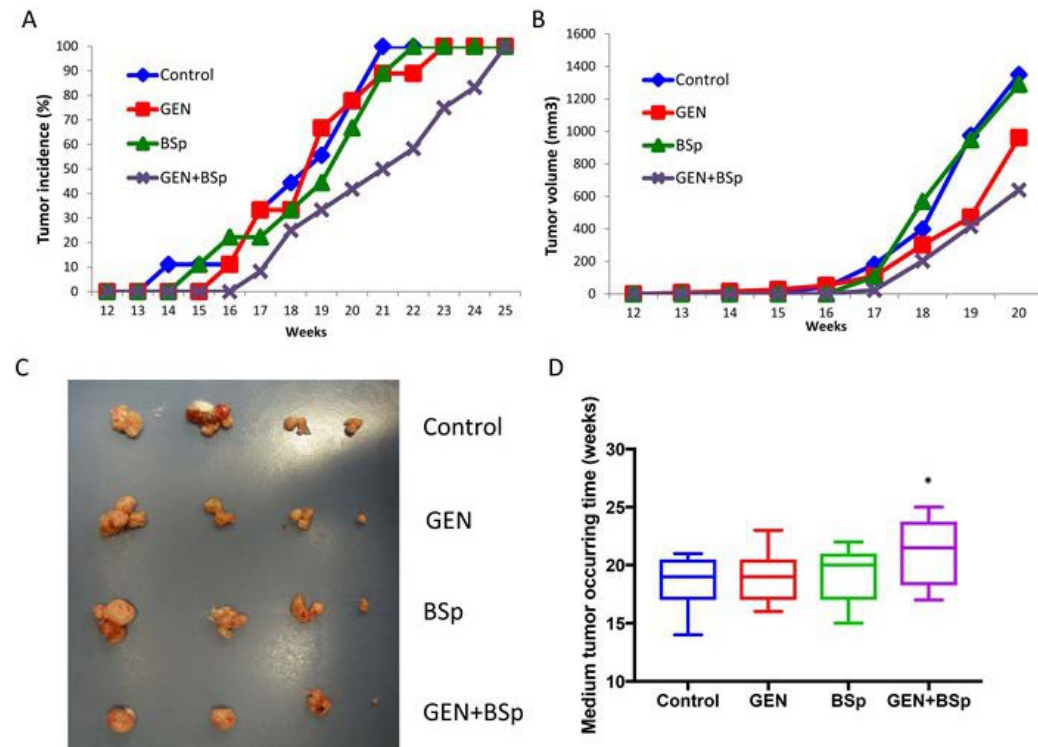
Figure 11. Tumor data analysis. Tumor inhibitory effects of dietary GEN and broccoli sprouts (BSp) on tumor growth of the ERα (−) transgenic mammary cancer C3(1) -SV40 (SV40) mouse model. Female SV40 mice (9–12 per group) were administered either regular control diet, GEN diet (250 mg/kg), 13% BSp diet or the two diets in combination from four weeks of age until termination of the experiment. Tumor volumes and sizes were observed weekly. ( A ) tumor incidence; ( B ) tumor volumes; ( C ) representative photographs of mammary tumors in different experimental groups when harvested at the termination of the experiment; ( D ) tumor latency. * p < 0.05, significantly different from the control group.